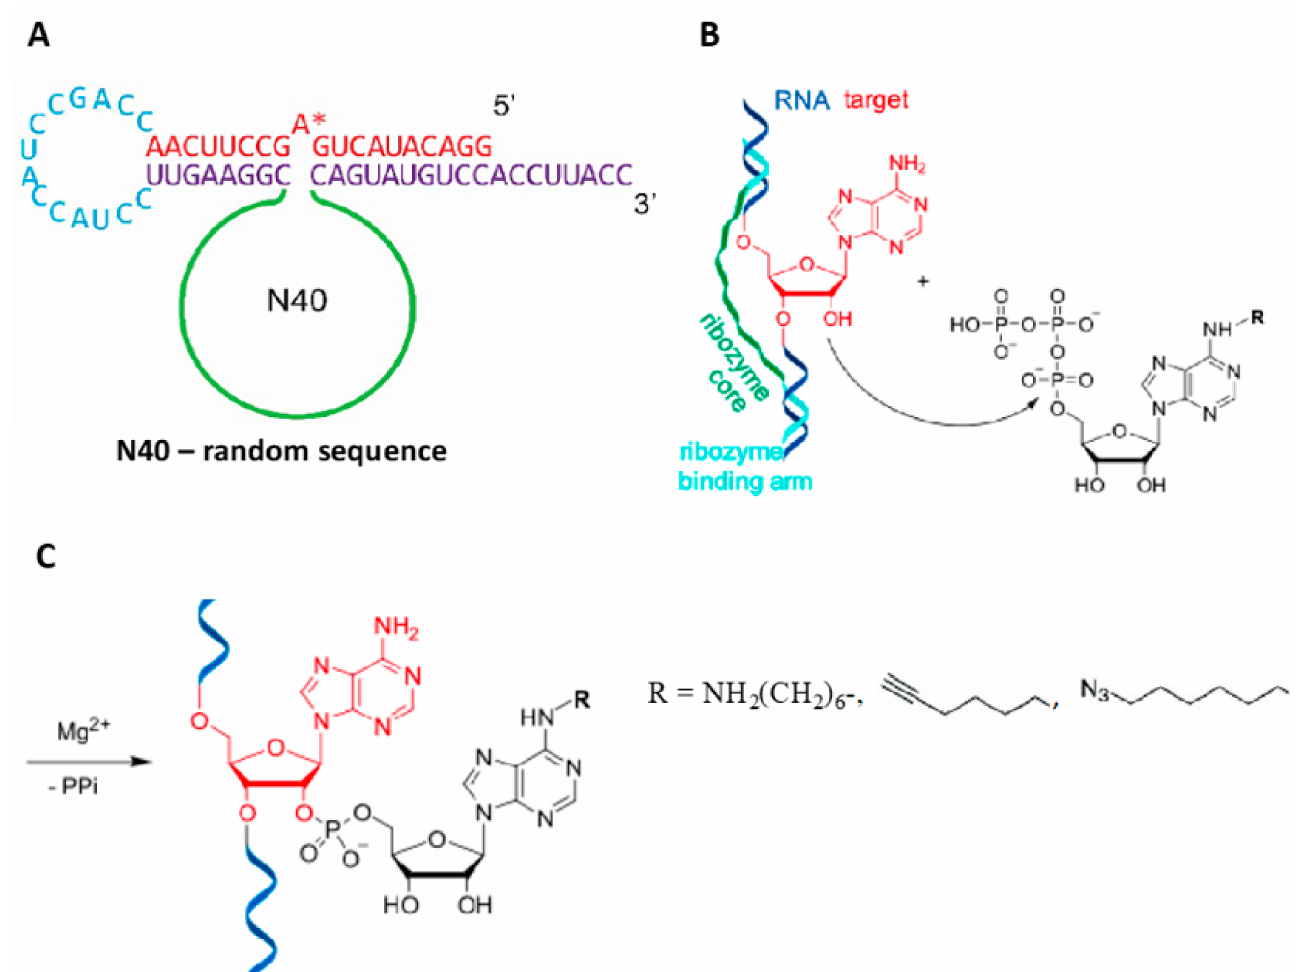
Figure 7. ( A ). RNA catalysts for labeling of a specific adenosine (starred) within a model sequence in cis were identified from a partially structured random RNA pool (N40). The constant region of the RNA pool contained the hypothetical substrate sequence and a pair of recognition arms complementary to the substrate sequence. ( B ). The labeling reaction involving N 6 -substituted ATP adenylylating the 2’ hydroxyl of the targeted adenosine. ( C ). The product of reaction shown in B showing substitutions used for fluorophore labeling. Adapted with permission from reference